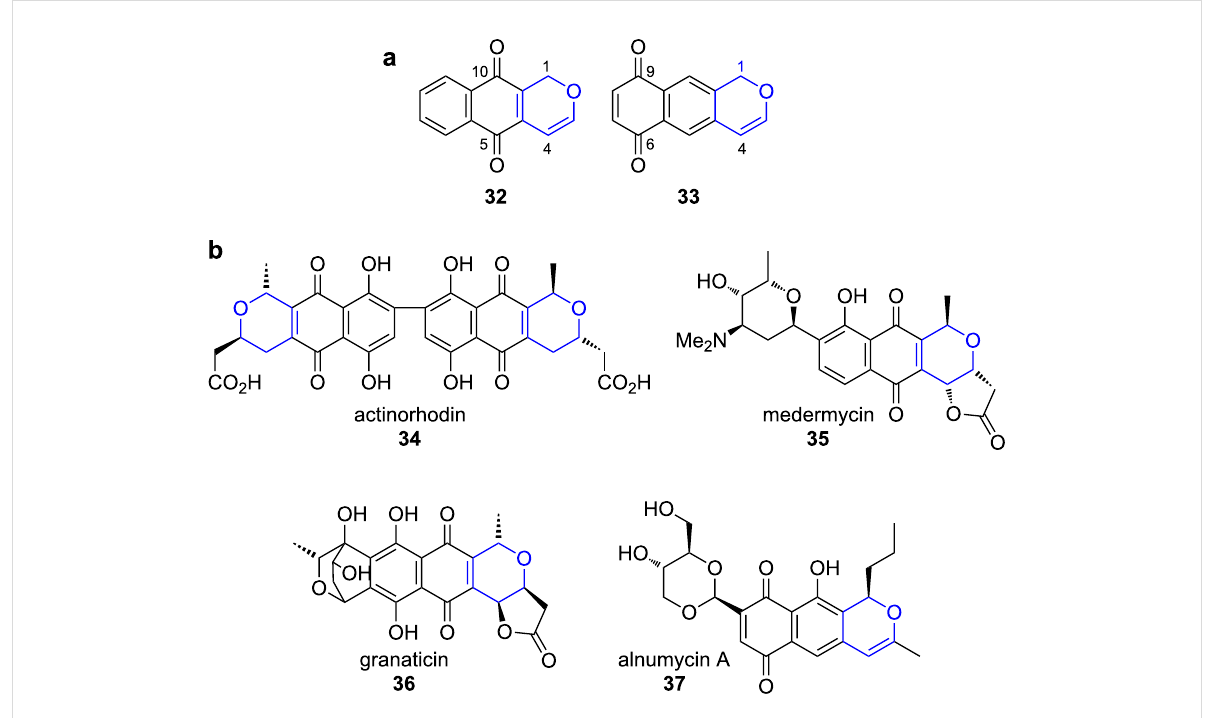
Figure 1: All pyranonaphtoquinones contain either the naphtha[2,3- c ]pyran-5,10-dione ( 32 ) or the regioisomeric naphtha[2,3- c ]pyran-6,9-dione ( 33 ) unit. Representative examples are actinorhodin ( 34 ), medermycin ( 35 ), granaticin ( 36 ) and alnumycin A ( 37 ) [21].